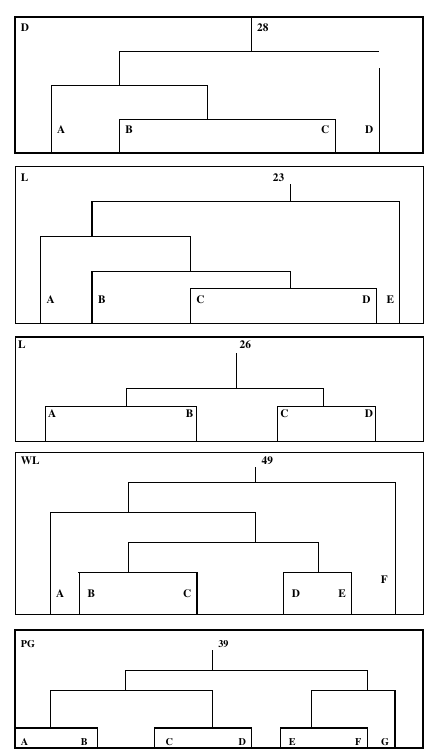
Fig. 2. The 26 vegetation groups yielded after the application of Twinspan for classification of vegetation in the five habitats: D=Desert, HG=Home gardens, L=Lawns, WL= Waste lands, and PG=Public